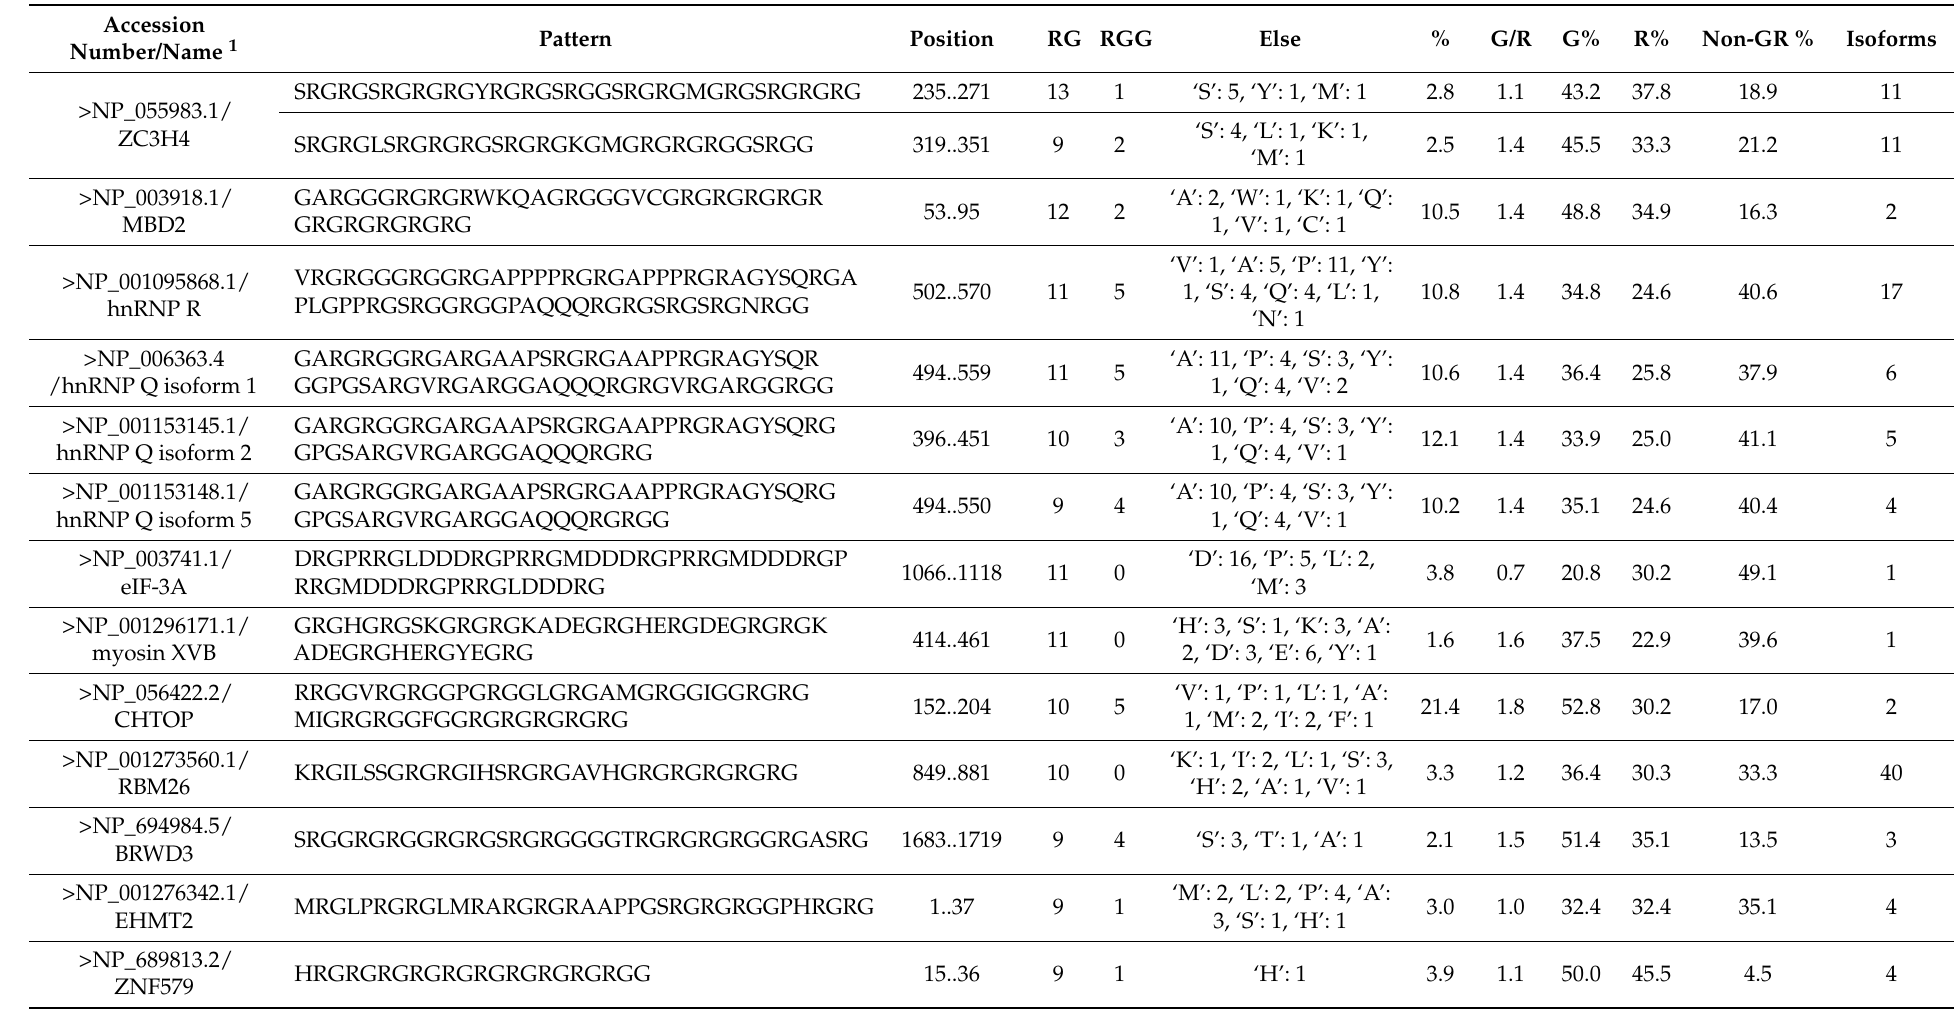
Table 4. Analyses of GAR motifs with the number of RG plus RGG repeats of more than 10 in human proteome by